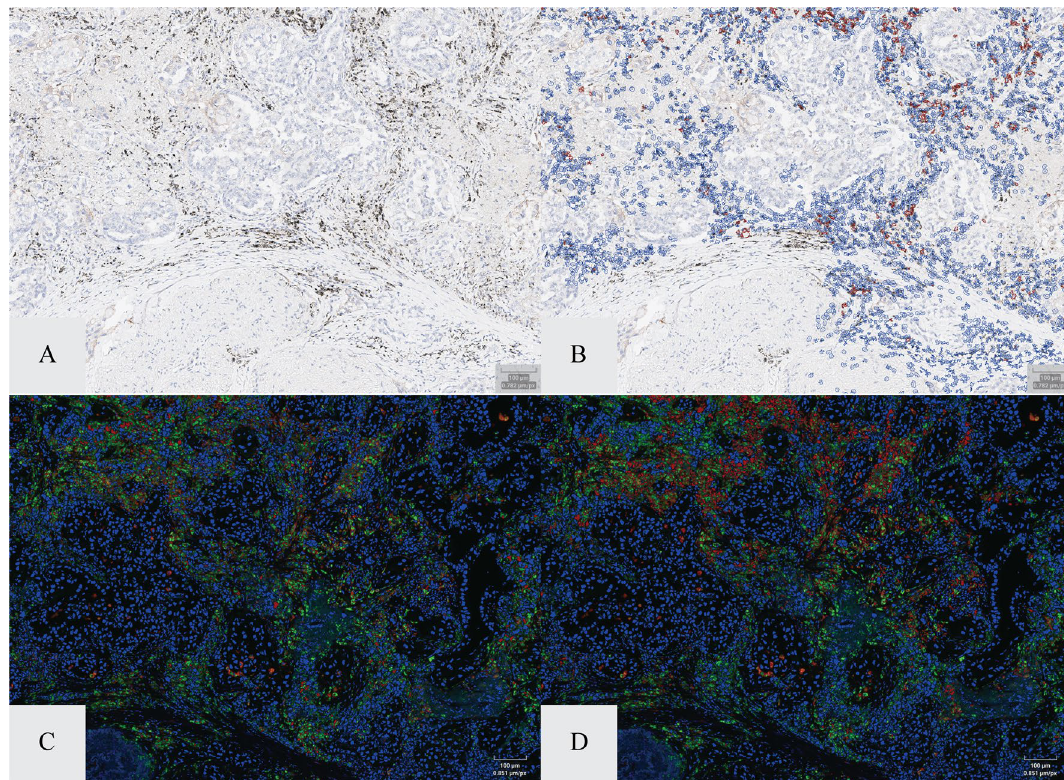
Figure 1. IA vs. double immunofluorescence of macrophage identification. Panel ( A ) and ( B ) show PD-L1 stained tumor field of view with and with out the macrophage algorithm labeling (red = PD-L1 positive; blue = PD-L1 negative). Panel ( C ) and ( D ) represent corresponding field of view in a serial section stained with CD68 (green) and CD163